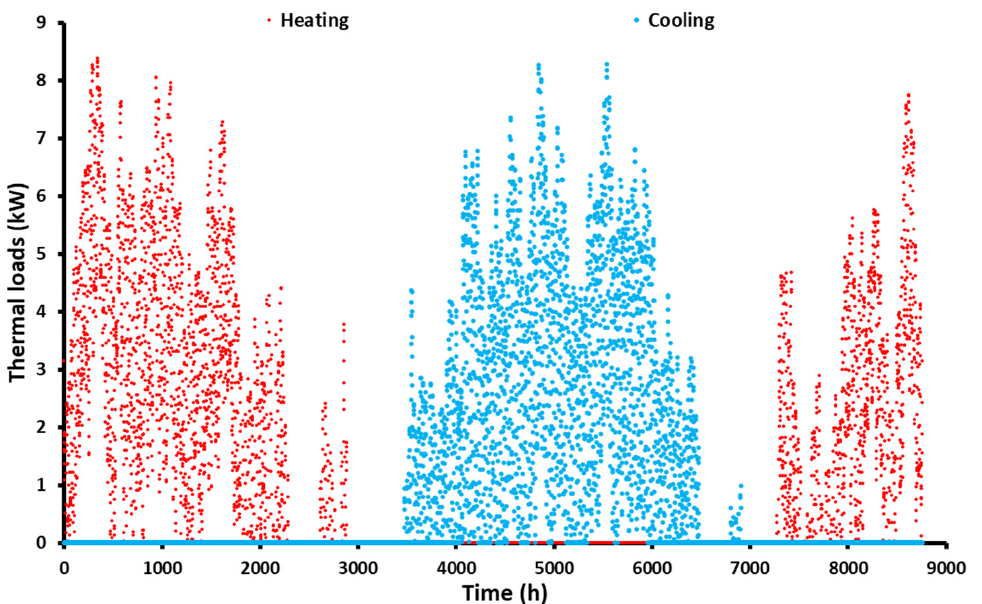
Figure 5. Heating and cooling thermal loads of the studied building.